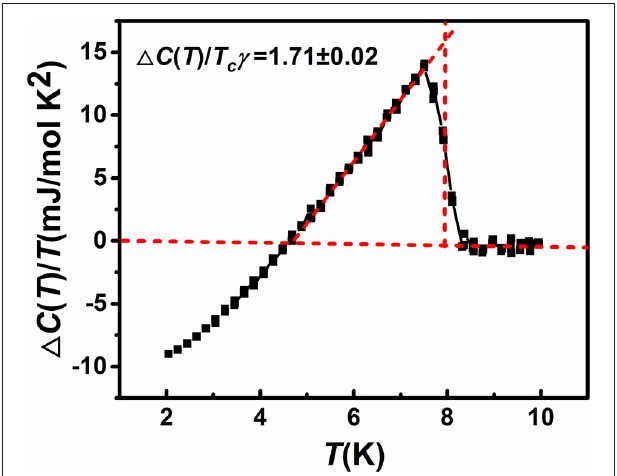
FIGURE 6 | 1 C ( T ) / T vs. T at H